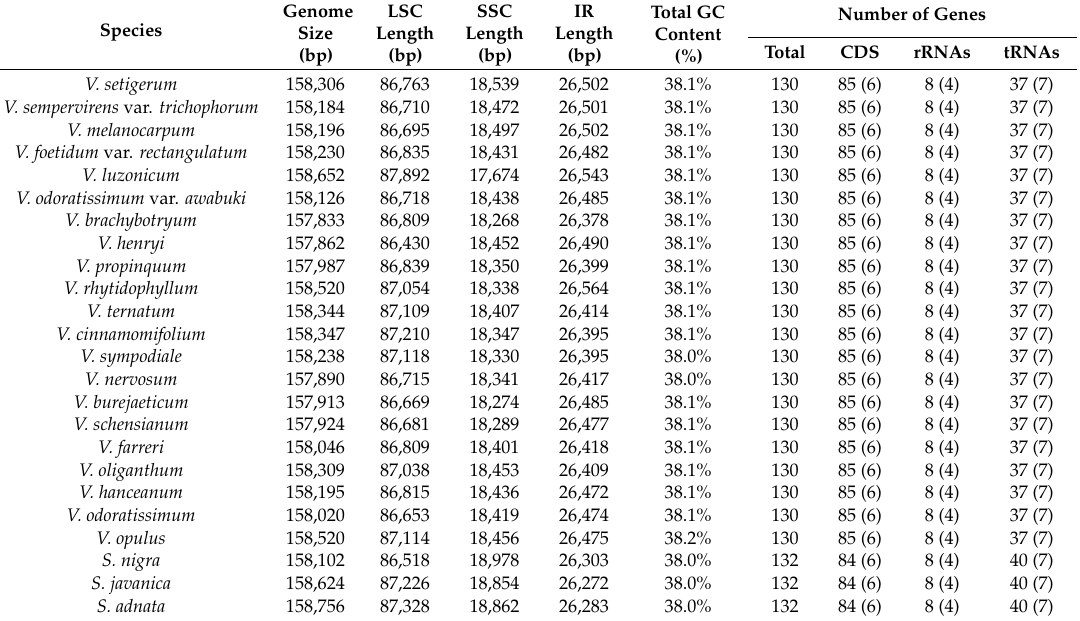
Table 1. Summary of the main characteristics of Adoxaceae